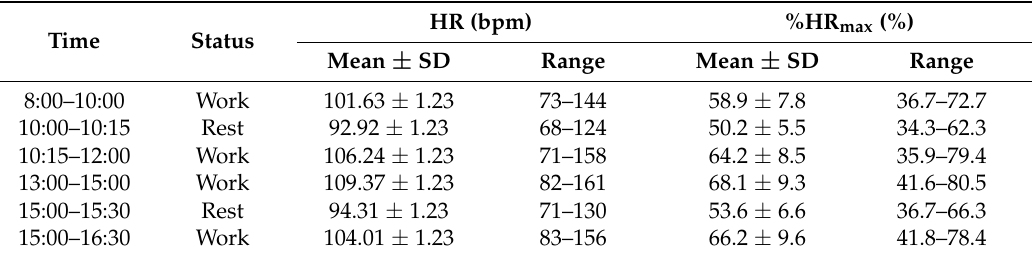
Table 3. Descriptive statistics of the HR data at different times.